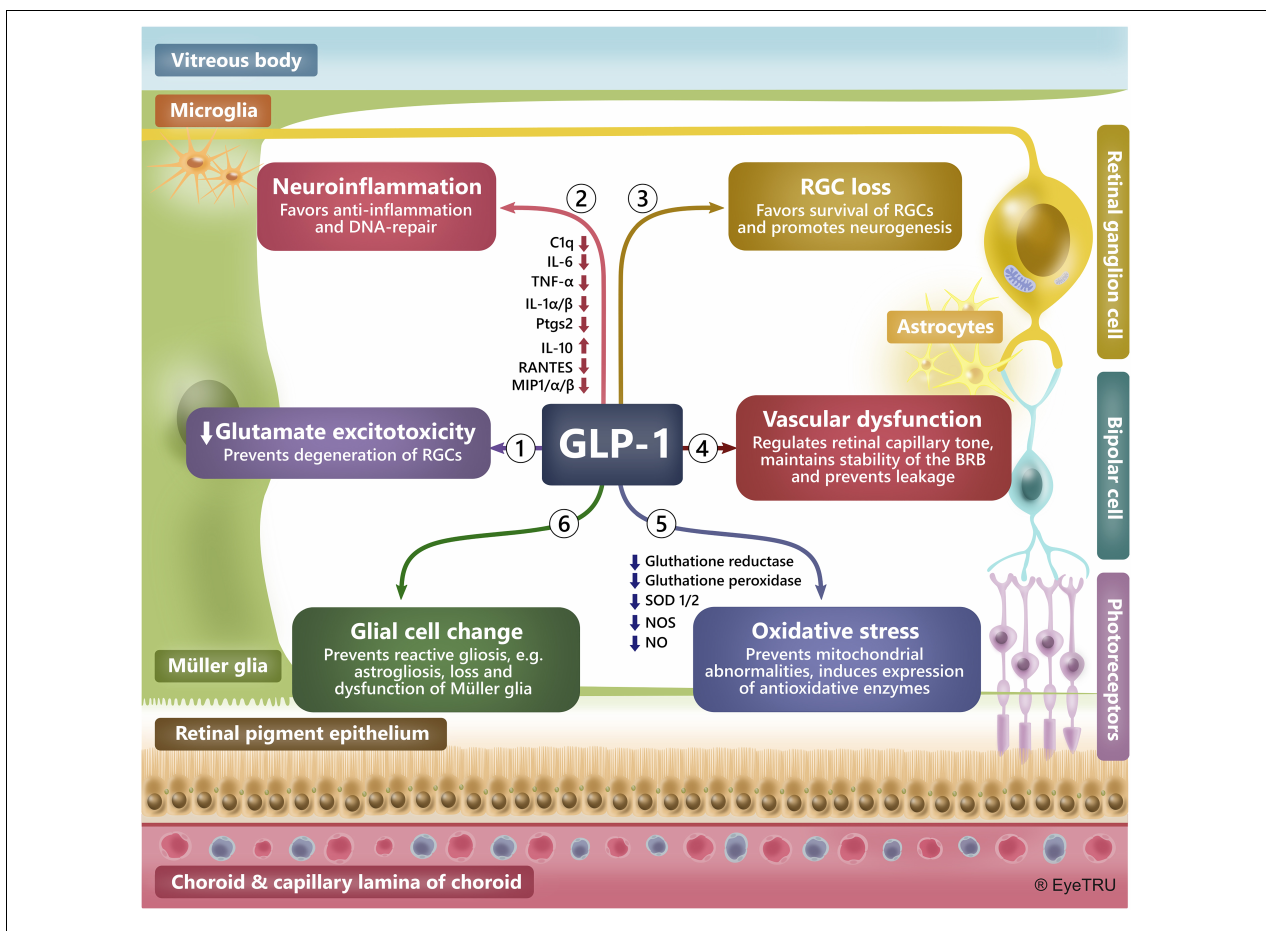
FIGURE 2 | Mechanisms behind a neuroprotective effect of GLP-1R agonists in the retina. Preclinical studies have demonstrated a glia- and neuroprotective effect of GLP-1R agonists in the brain and retina. In the retina GLP-1R agonists have shown to protect against neurodegeneration by preventing: (1)